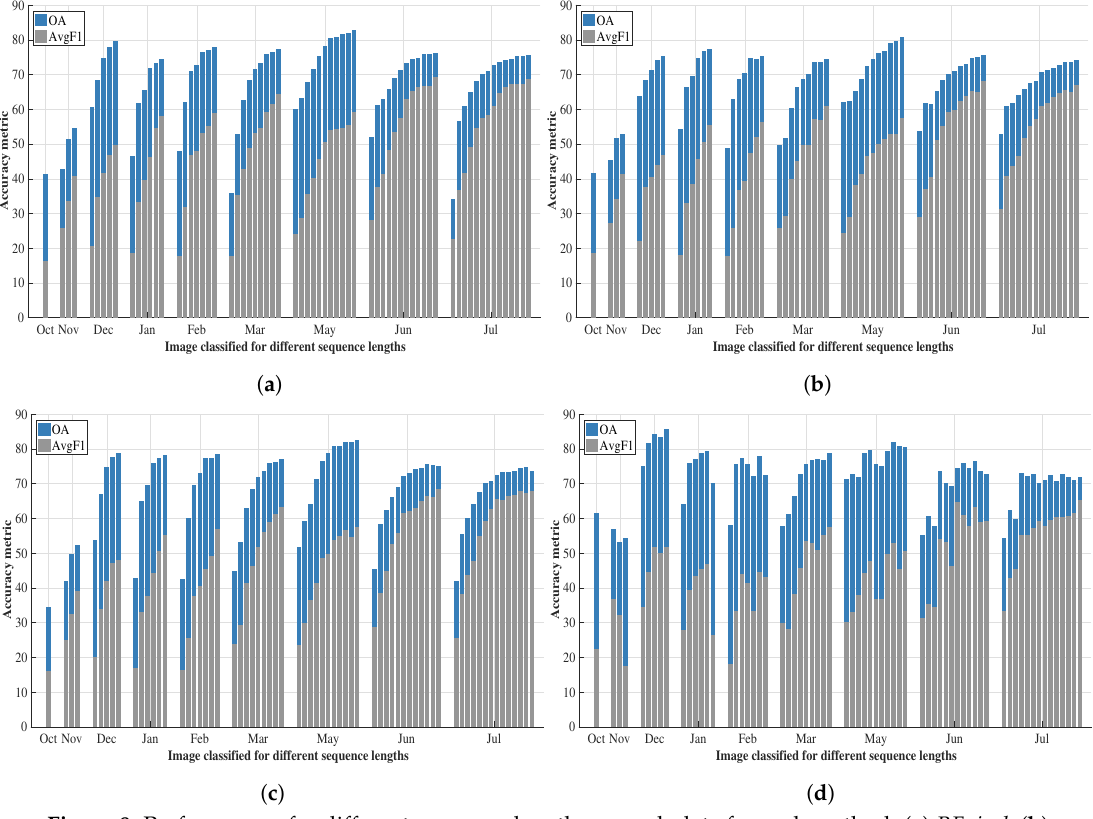
Figure 8. Performances for different sequence lengths on each date for each method: ( a ) RFpixel , ( b ) AEpatch , ( c ) CNNpatch and ( d ) FCNpixel . OA (blueish bars) and average F1 (grayish bars).